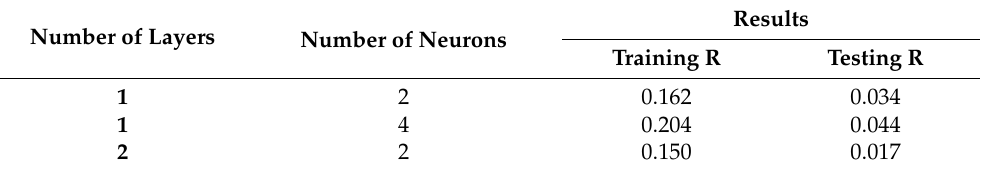
Table 4. Sensitivity analysis for ANN. Number of